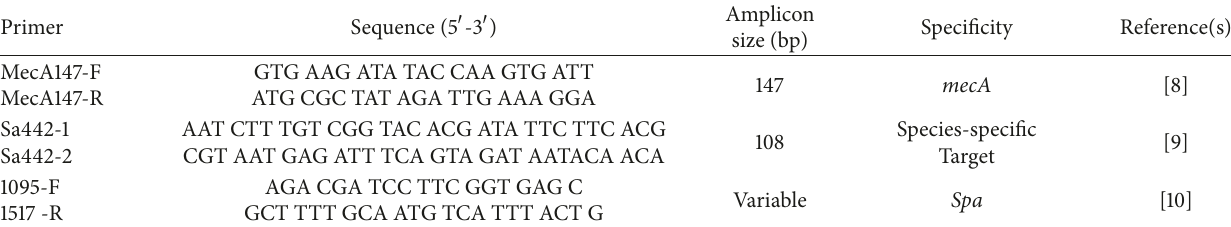
Table 1: Summary of primers used in this